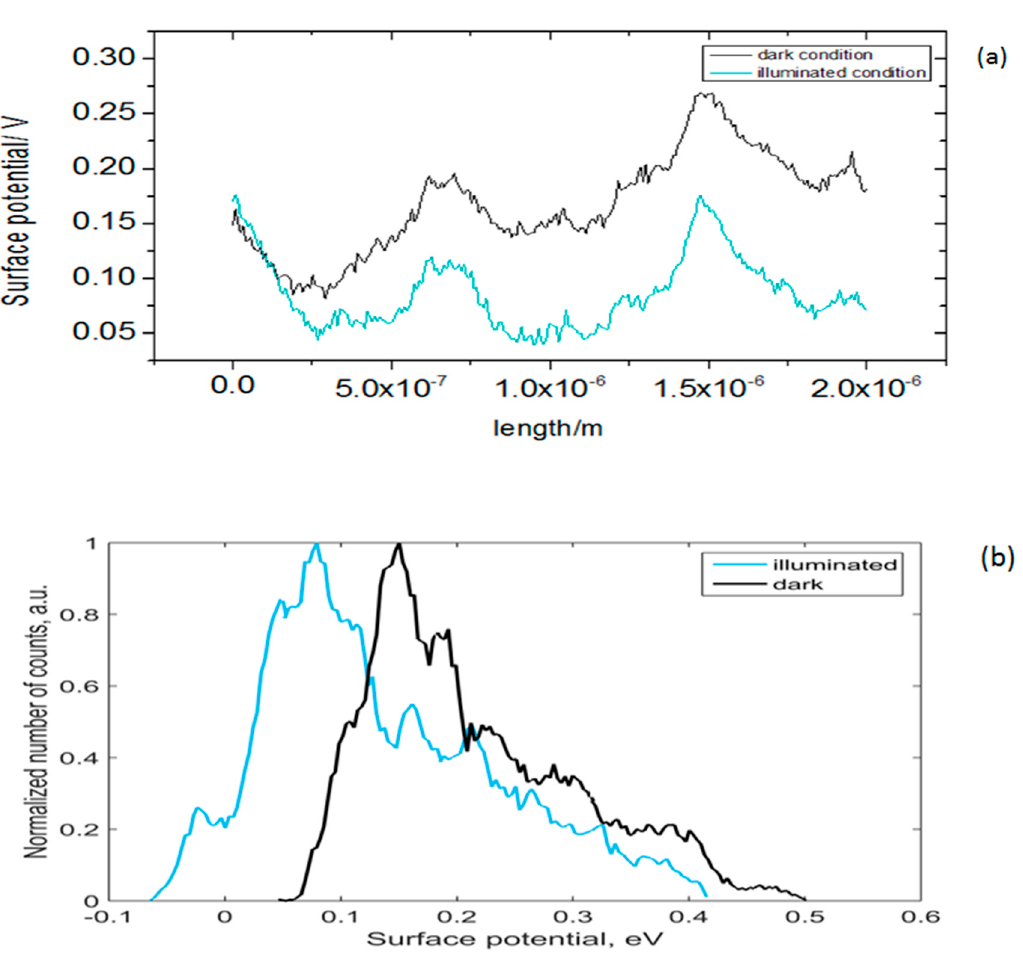
Figure 13. Graph of ( a ) the V CPD profiles of the as-etched silicon nanoflakes under dark and illumination conditions and ( b ) V CPD distribution .